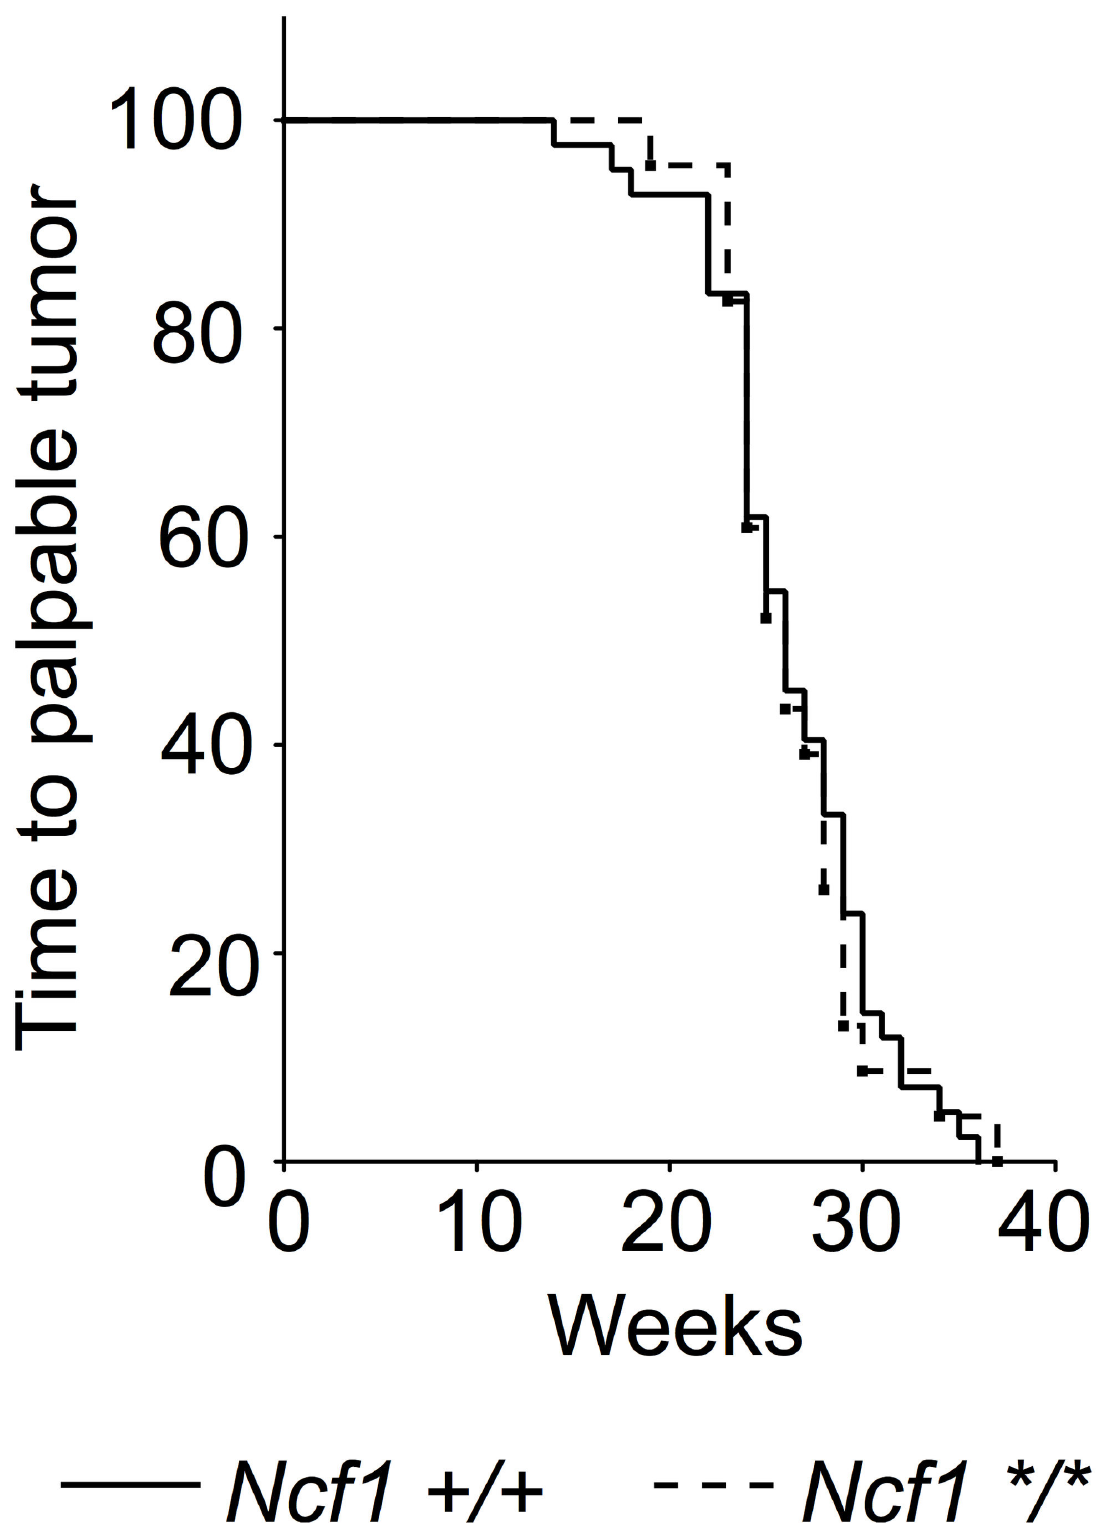
Figure 5. Survival of TRAMP mice with ( Ncf1 */* , n=23) and without ( Ncf1 +/+ , n=42) Ncf1 m1J mutation displayed as Kaplan-Meier curve, log rank test.